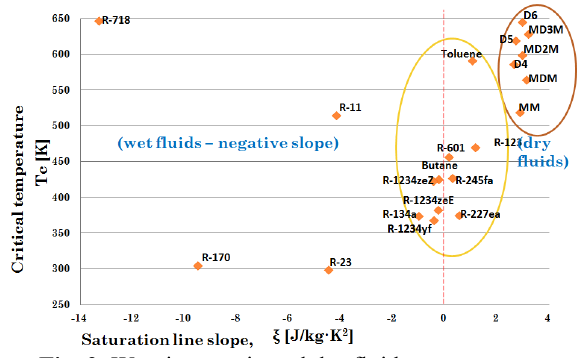
Fig. 2. Wet, isentropic and dry